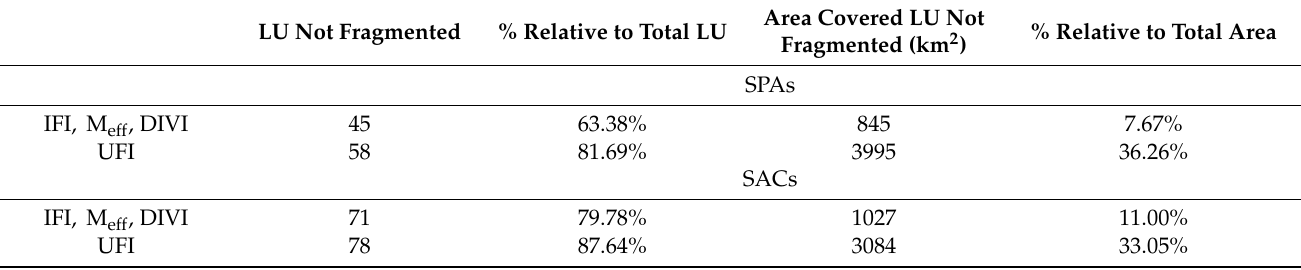
Table 6. Results for the number and surface area of non-fragmented landscape units. Area Covered LU LU Not Fragmented % Relative to Total LU